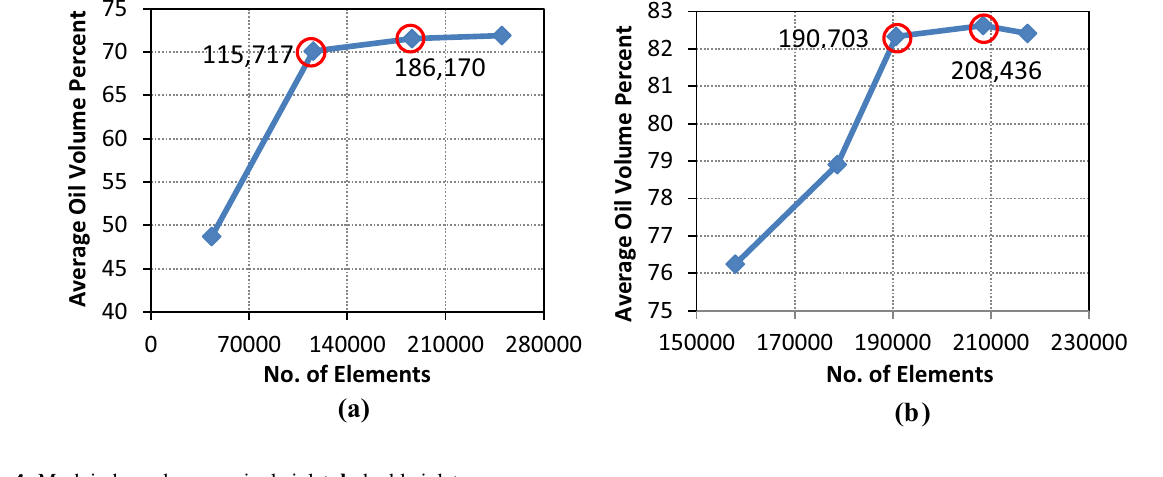
Fig. 4 Mesh independency: a single inlet; b double